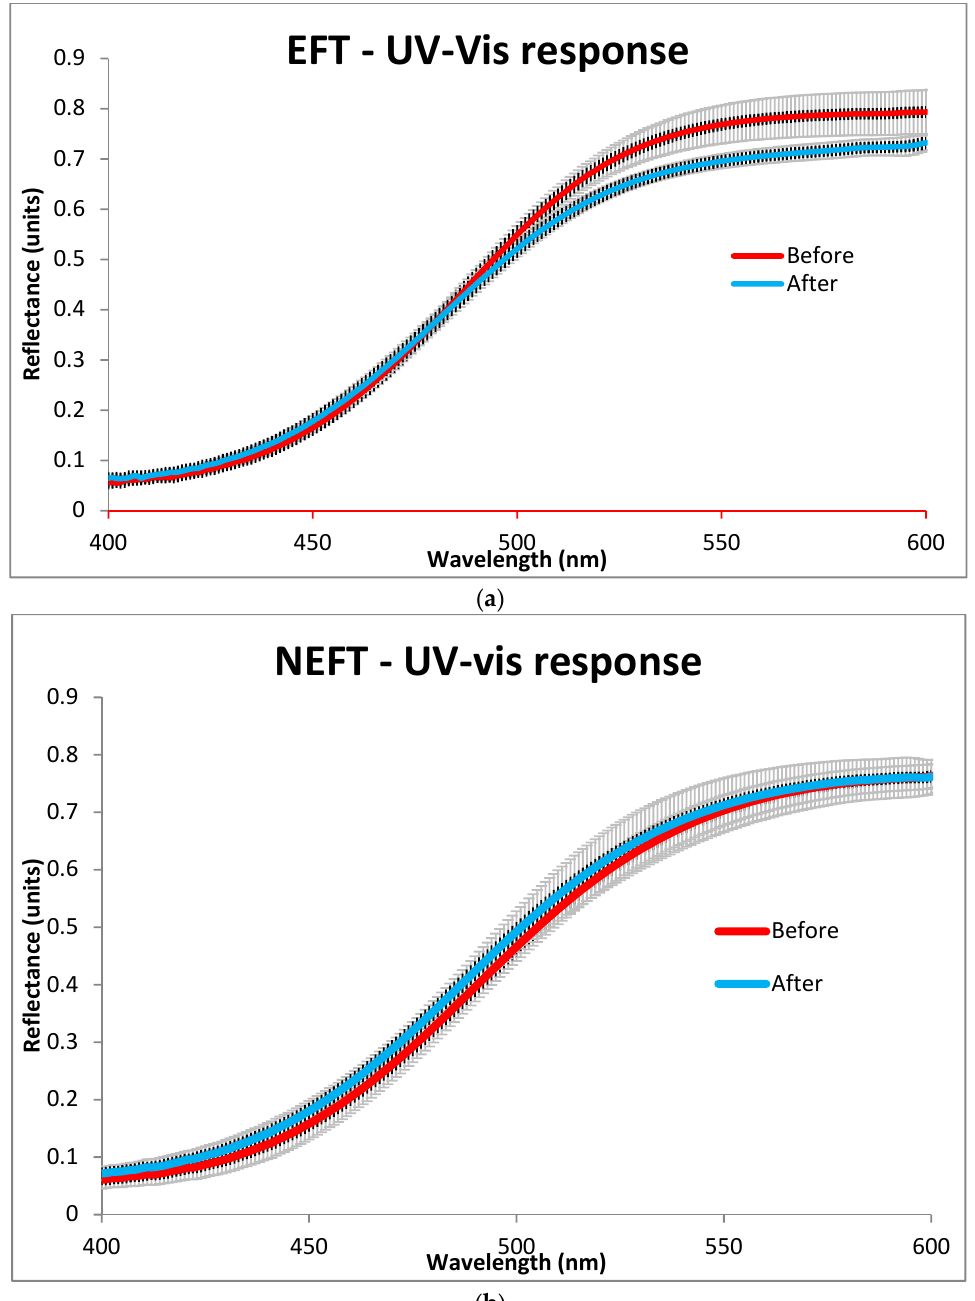
Figure 6. UV-VIS spectroscopy results from reactive chemistry patches. ( a ) EFT before ( Red ) and after ( Blue ); and ( b ) NEFT before ( Red ) and after ( Blue ).